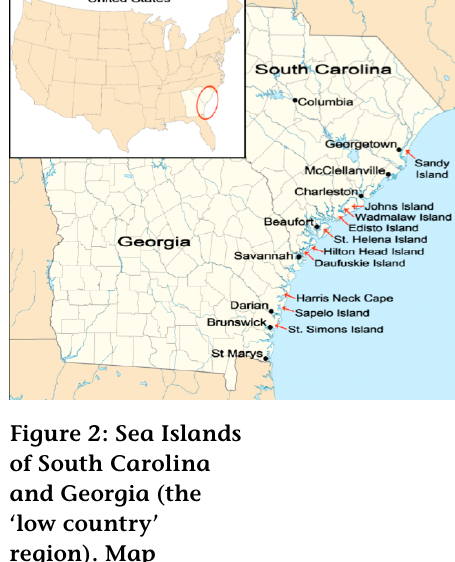
Figure 2: Sea Islands